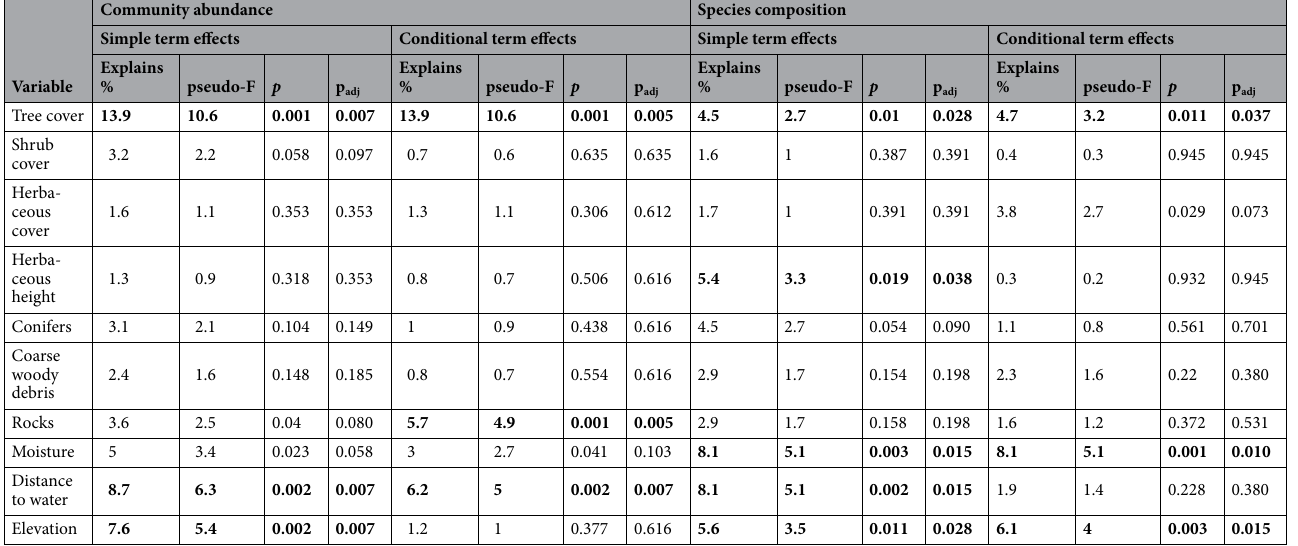
Table 3. Simple and conditional effects of the habitat variables on the community abundance and species composition of small mammals in the study area. Values of the explained variation (Explains %), pseudo-F, significance ( p ) and False discovery rate (p adj ) are presented. In bold are predictors with significant effects (p adj <